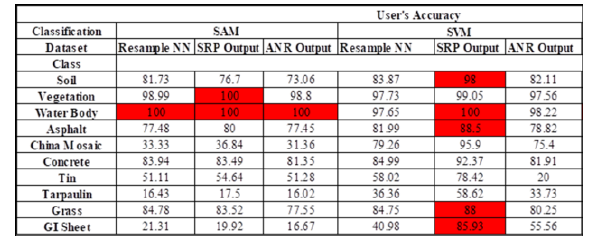
Table 5. UA for Individual Class of Three